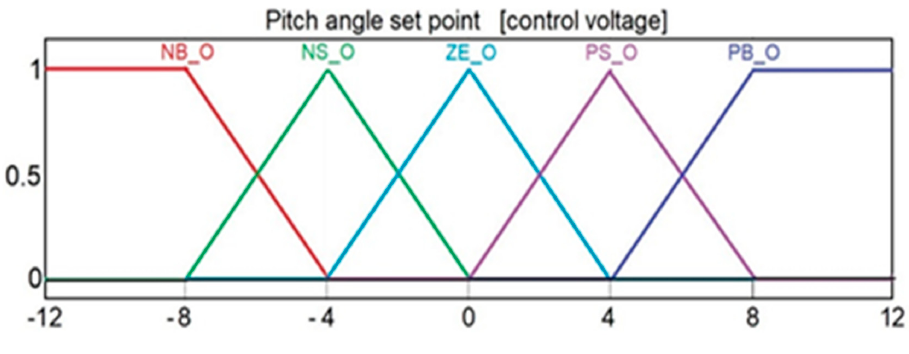
Figure 14. Membership functions for output value.